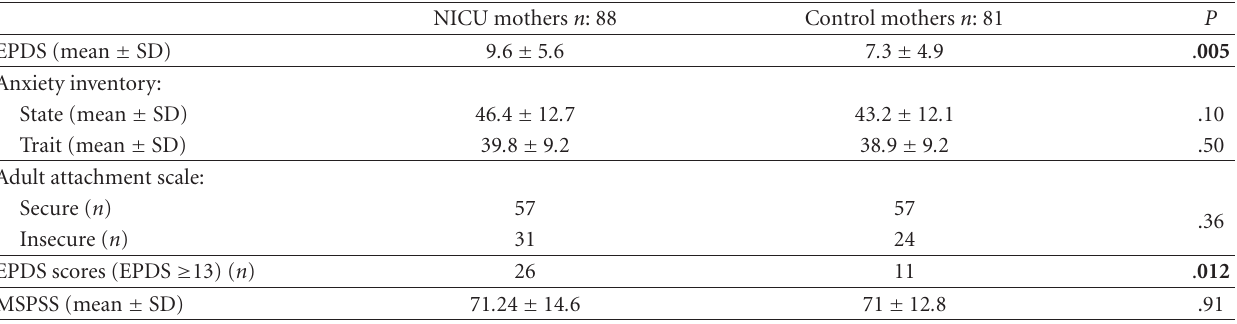
Table 3: Psychological adjustment of NICU and control